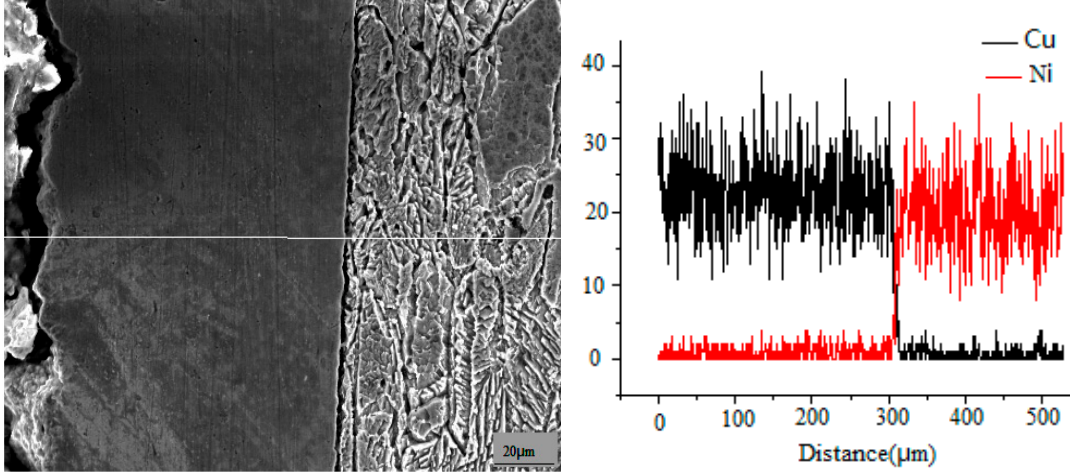
Figure 4. Distributions of Cu and Ni along the cross ‐ section of the Ni/n–Al 2 O 3 layer.